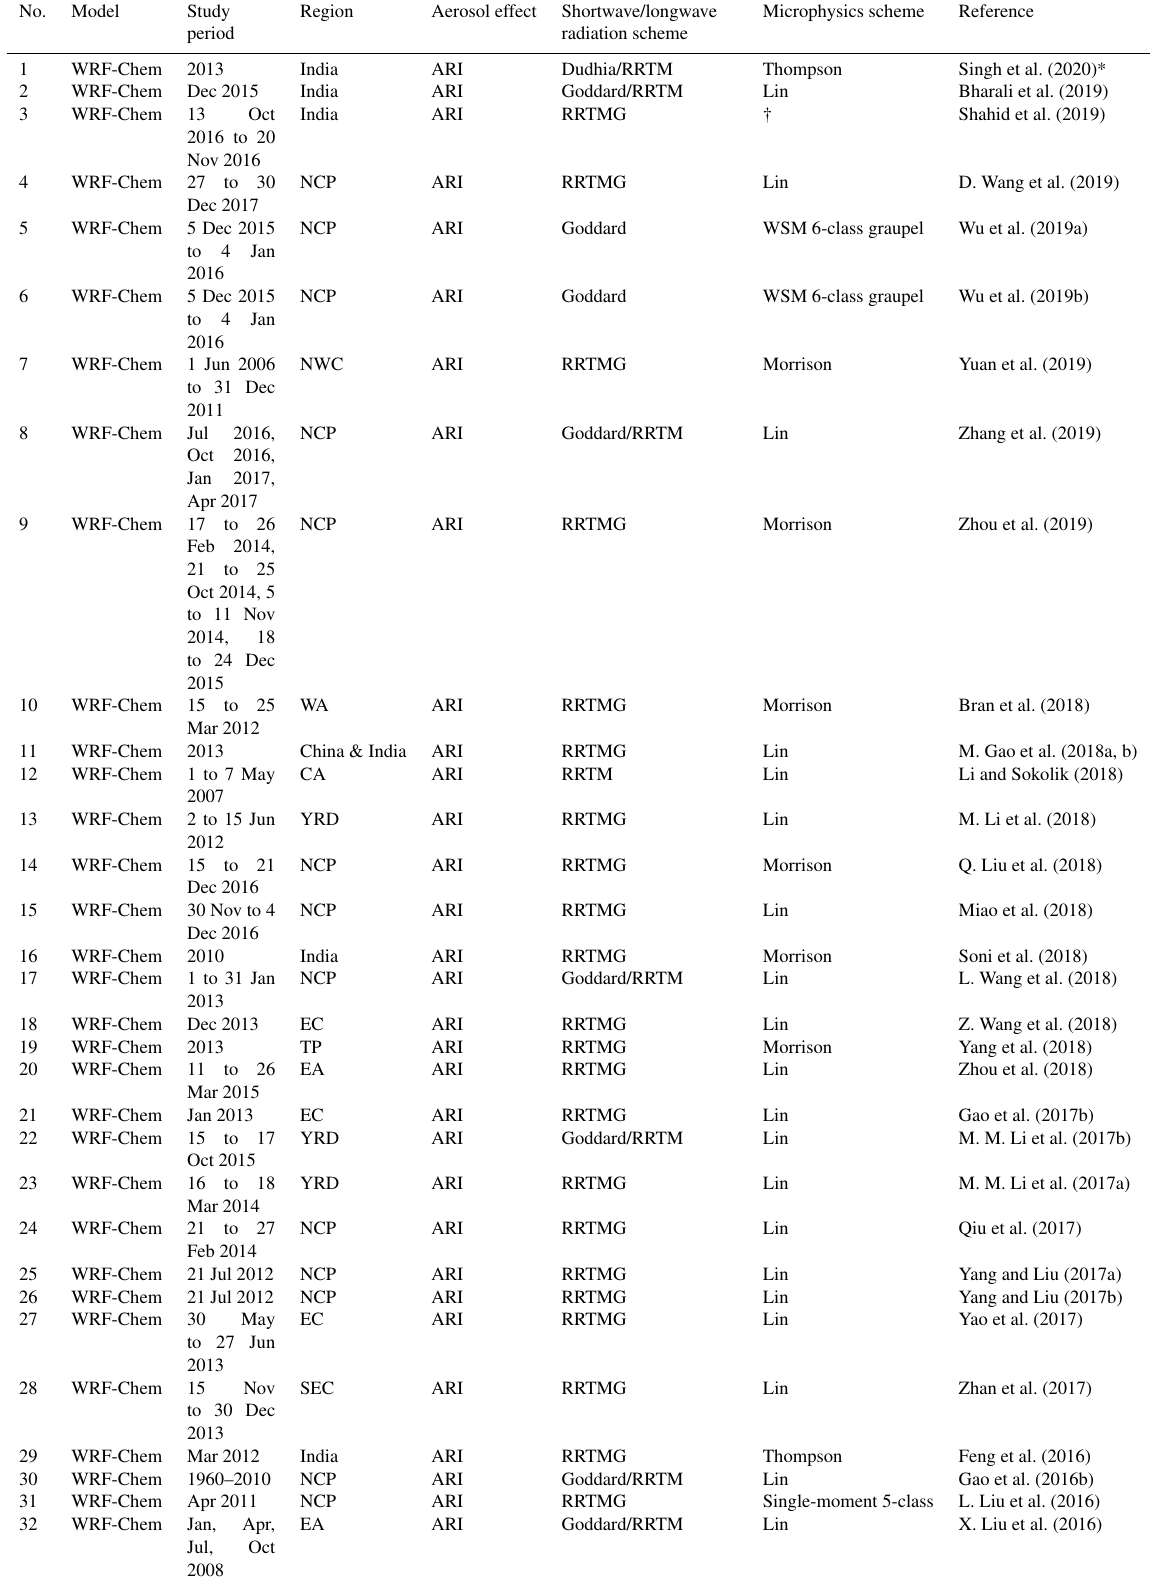
Table 1. Basic information on coupled model applications in Asia during